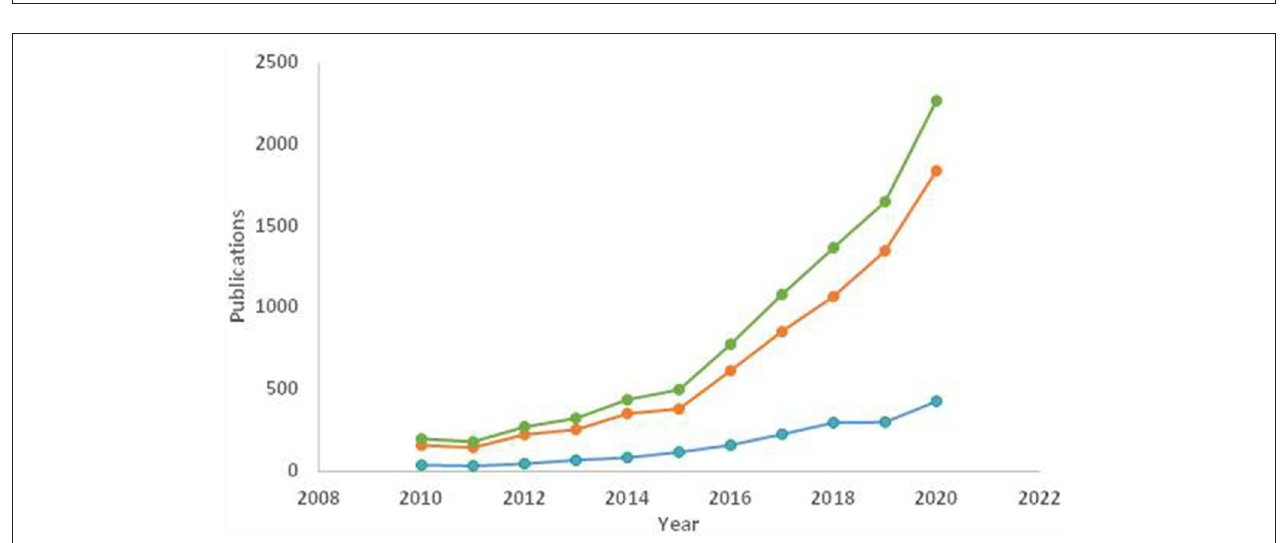
FIGURE 6 | Evolution of the number of publications during the last 10 years (2010–2020) with the terms “smart food packaging” ( (cid:4) ), “active” ( (cid:4) ), and “intelligent” ( (cid:4) ), as title and/or topic (Scholar Google, March 2021, http://scholar.google.com). warn of possible problems (Yam and Lee, 2012).